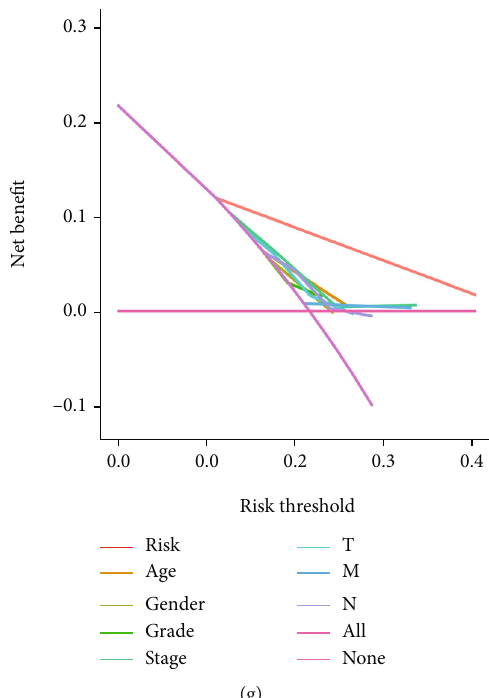
Figure 7: Independent prognosis value of the model. Correlation between the risk score and clinical characteristics (a). Correlation between the risk score and age (b). Correlation between the risk score and tumor stage (c). Correlation between the risk score and T stage (d). ROC curves were plotted to prove the superiority of the risk score (e). Univariate analysis and multivariable analysis were performed to validate the independent prognosis value of the model (f). Decision curve analysis (DCA) was performed to validate the clinical application accuracy of the risk model